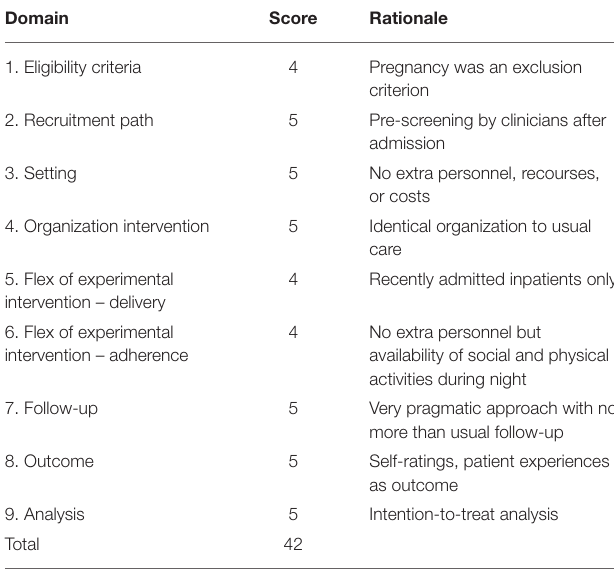
TABLE 1 | PRECIS-2 scores for trial